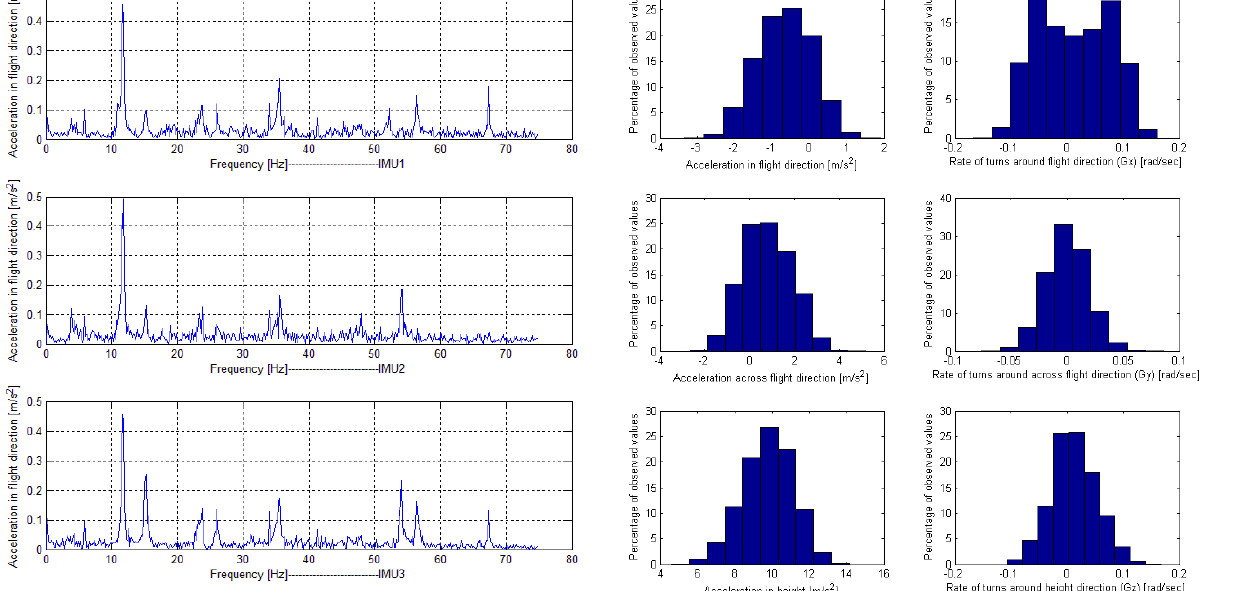
Figure 5. Comparison of histograms of the observed results for accelerations and rates of turn